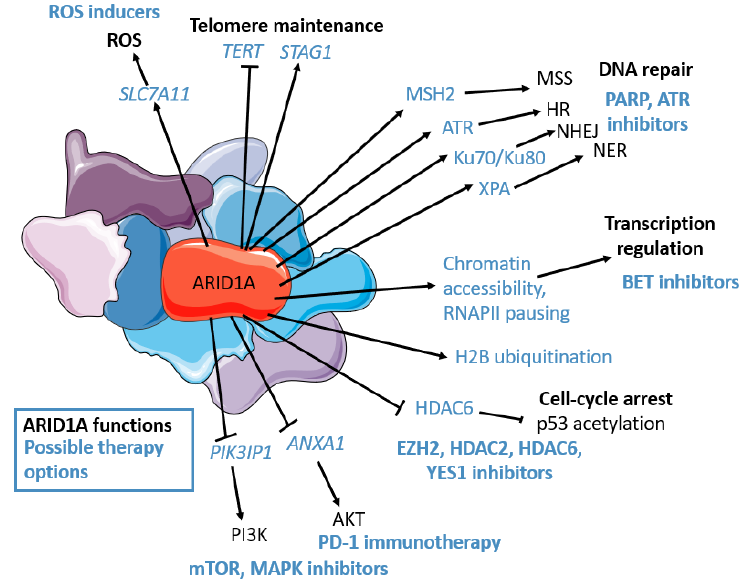
Figure 1. ARID1A’s functions (in black): transcriptional regulation (chromatin accessibility, epigenetic mark placement, RNAPII pausing regulation), PI3K/AKT/mTOR pathway regulation, cell-cycle regulation (p53 deacetylation through HDAC6), DNA repair: Homologous repair (HR) (RPA